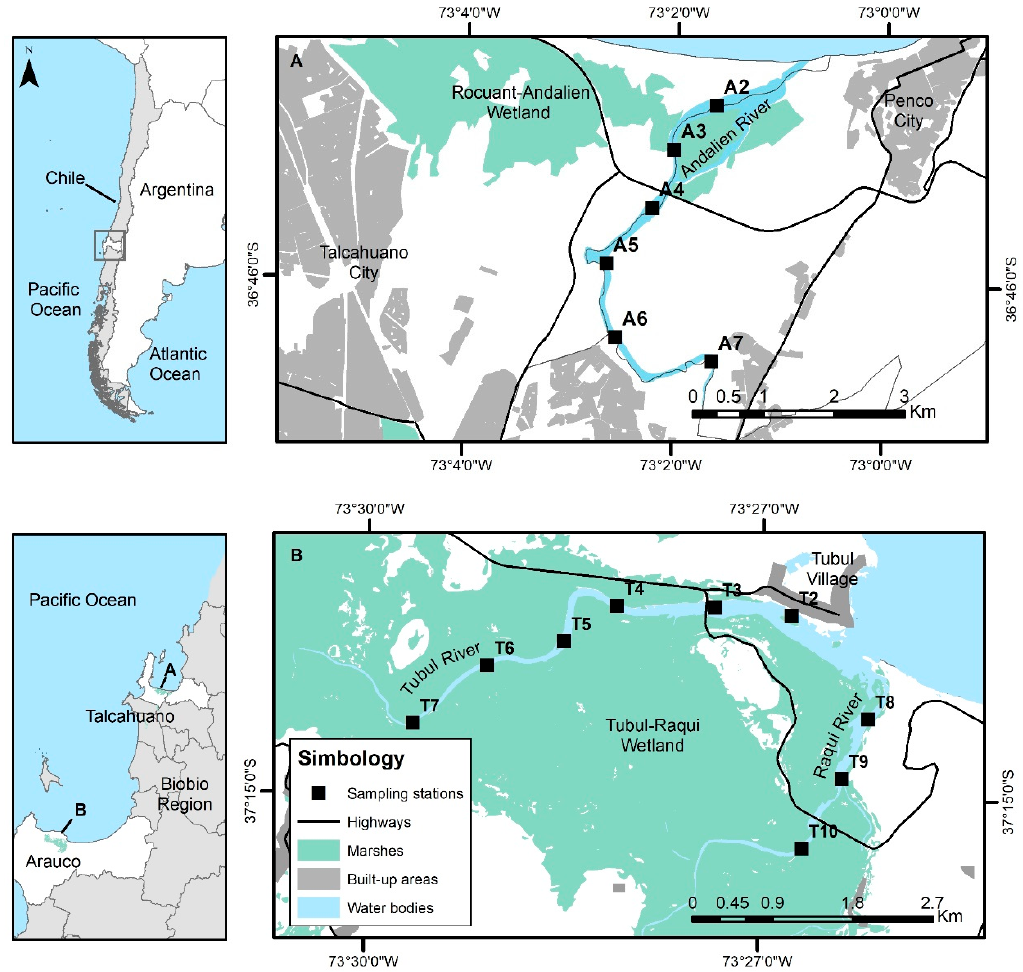
Figure 1. Study areas: ( A ) Rocuant-Andalién wetland, with locations of sampling stations ( n = 6) in the Andalién River, the main aquatic system of the wetland; and ( B ) Tubul-Raqui wetland, with sampling stations in the Tubul ( n = 6) and Raqui ( n = 3) rivers.